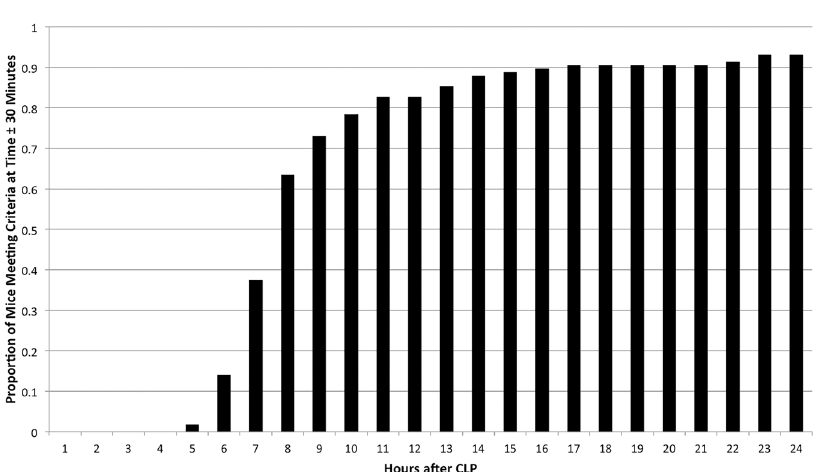
Figure 2. Cumulative proportion of mice meeting threshold for acute physiologic deterioration. The collective proportion of the total cohort (n = 115) of mice which has reached criteria for acute physiologic deterioration within thirty minutes of each hour after cecal ligation and